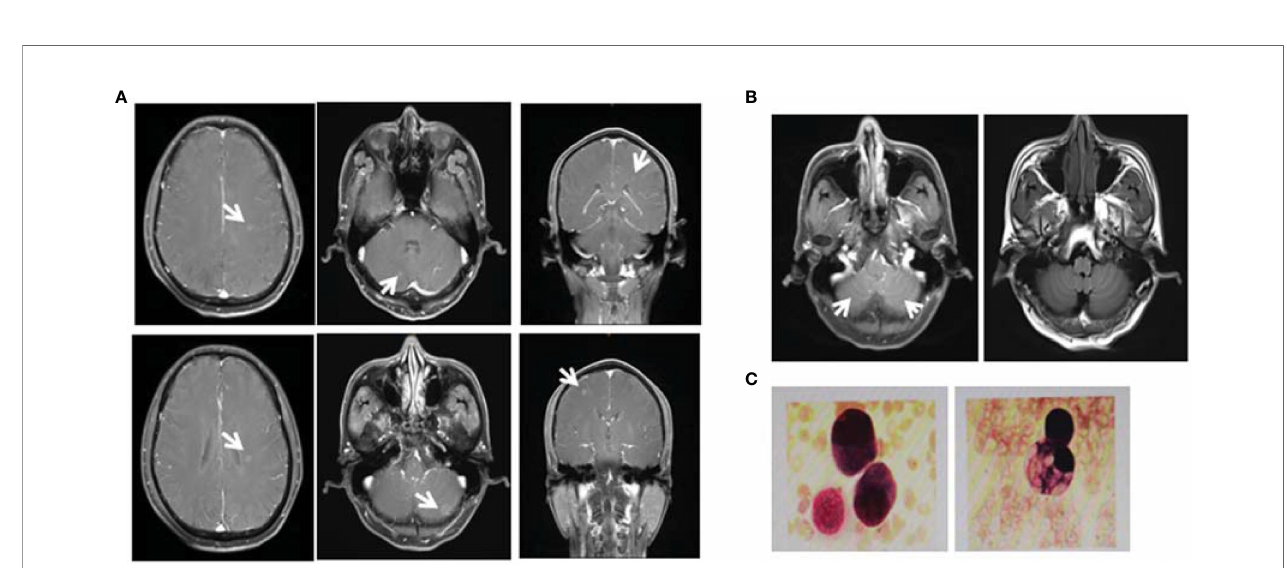
FIGURE 2 | Diagnosis of brain metastases. (A) On October 31, 2019, the magnetic resonance imaging (MRI) examination of the patient showed multiple brain masses including multiple metastases in the lateral ventricle, right frontal lobe, and cerebellar hemisphere. Diagnosis of leptomeningeal metastases. (B) On April 21, 2020, MRI T1 enhancement and FLARE examination showed that the cerebellar sulci had multiple line-like and spot-like enhancements, suggesting meningeal metastasis. (C) On April 30, 2020, retest of the cerebrospinal fl uid (CSF) showed the presence of cancer cells with the characteristics of adenocarcinoma cells.